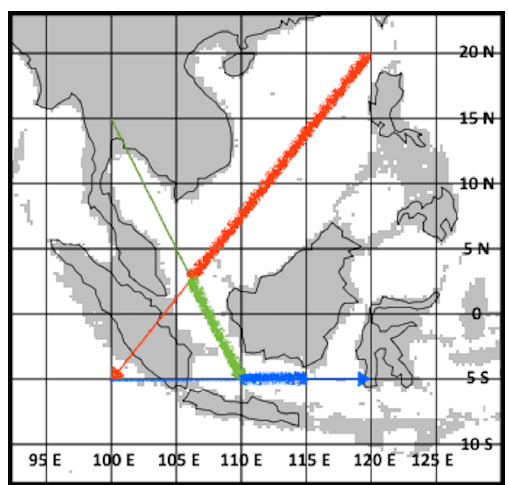
Figure 2. The paths along which cross-sections were